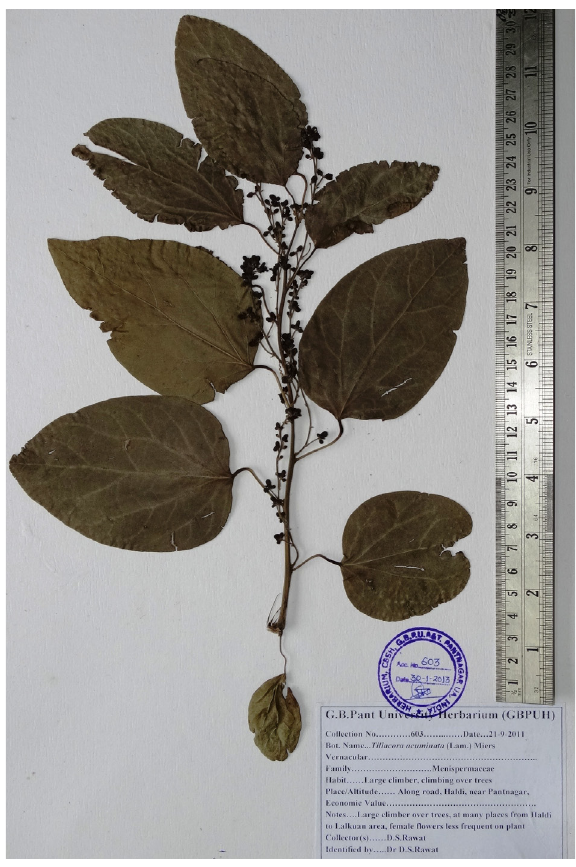
Image 2. Herbarium specimen of Tiliacora acuminata (Lam.) Miers